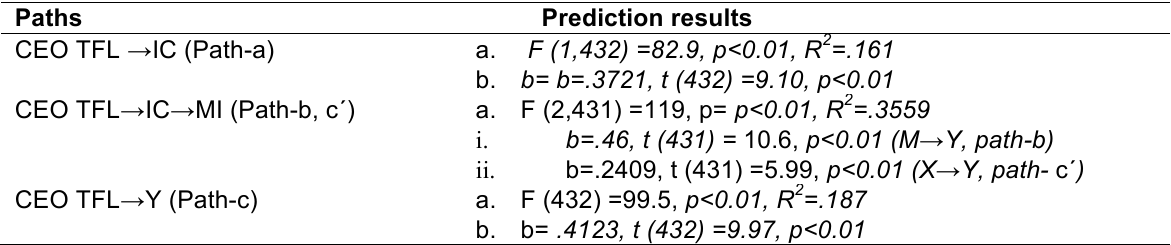
Table 5: Path analysis using Hayes bootstrapping